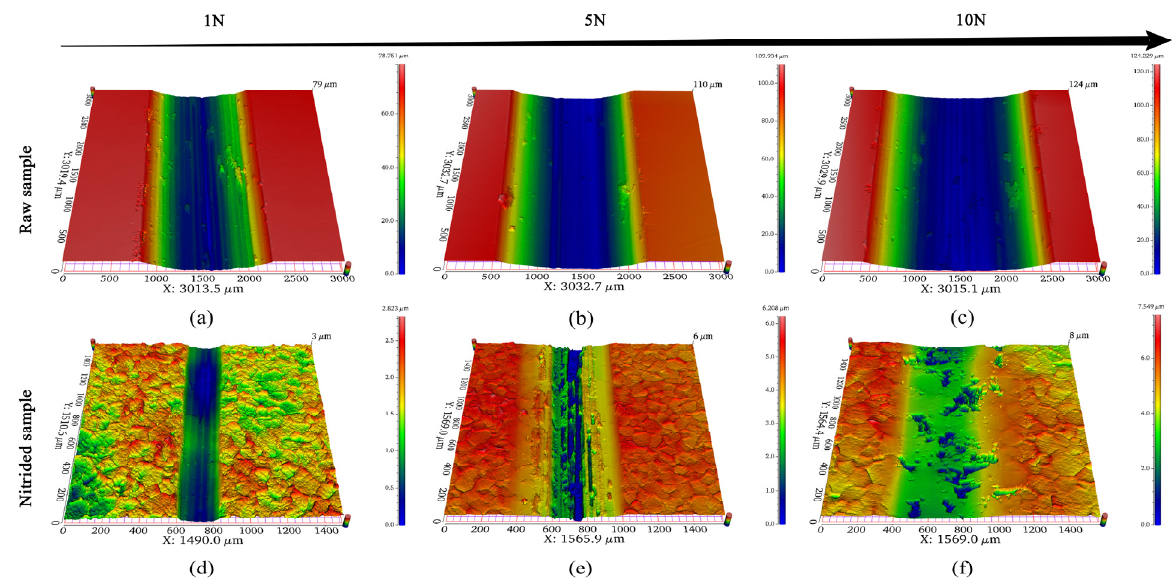
Figure 9. 3D wear morphology after the tribocorrosion test of the ( a – c ) raw sample and the ( d – f ) ni- trided sample at anodic applied potential (E = 1.0 V) in SBF